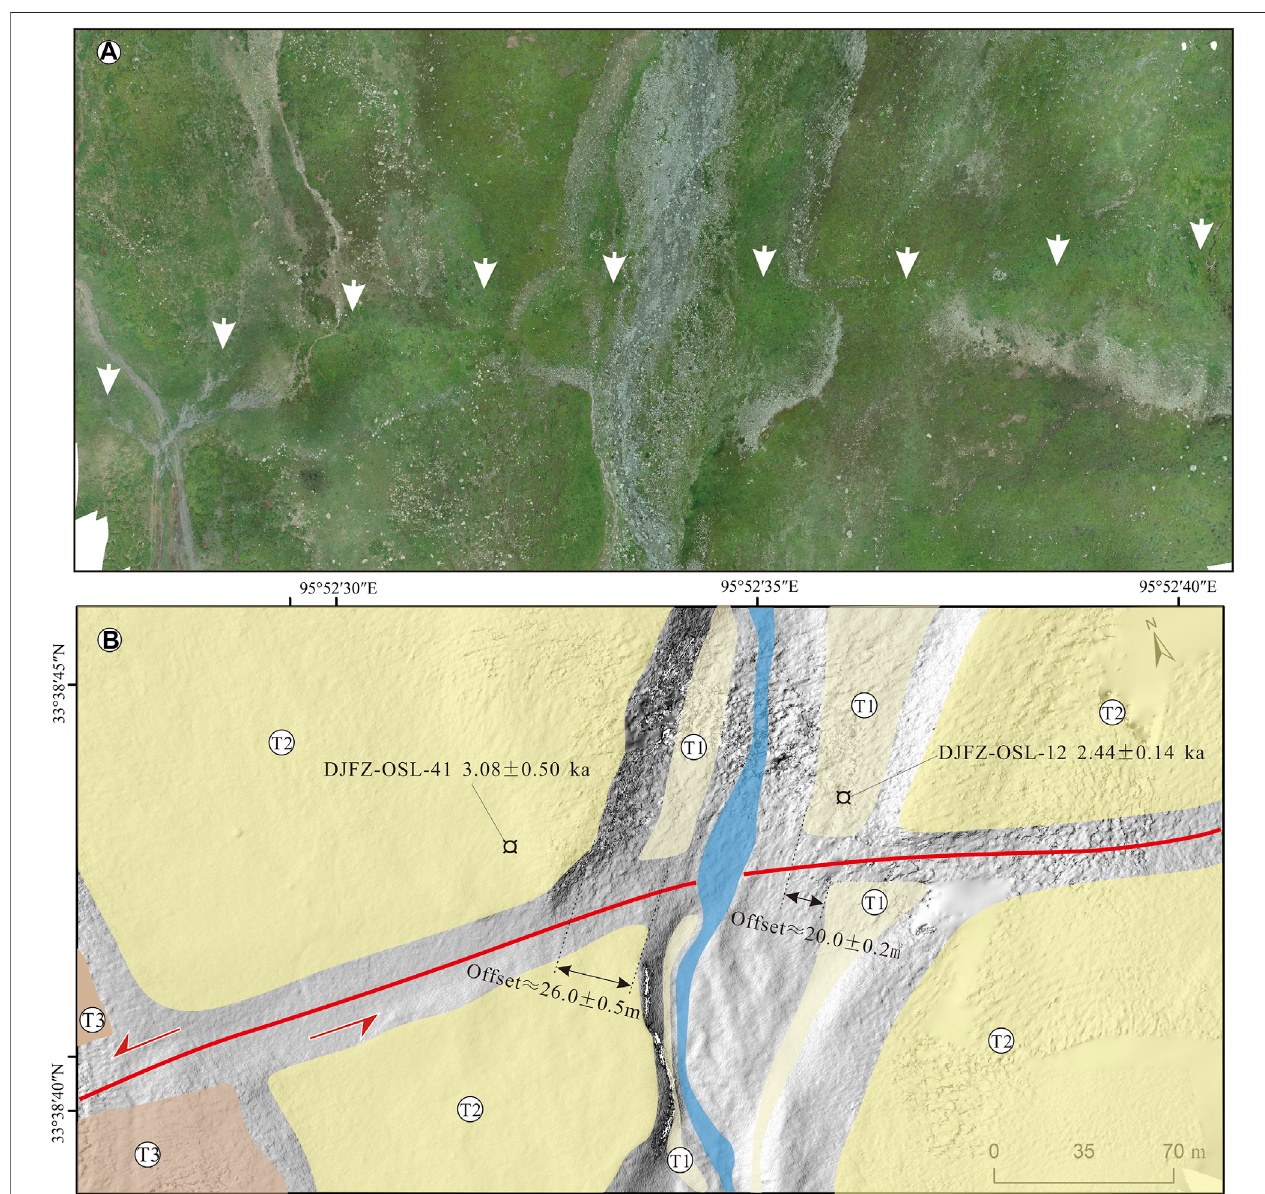
FIGURE 13 | Tectonic geomorphic features south of Riqing village in the middle section of the DJF (the study site is marked in Figure 3 M). (A) The orthophoto imagetakenfrom adroneshows thatthefaultactivity displaced thegullyandterraces,andthewhitearrows inthemapdelineatethefaulttrace. (B) Interpretedmapand fi eld investigation hint that the horizontal displacements of terraces T1 and T2 are ~20.0 ± 0.2 m and 26.0 ± 0.5 m, respectively. The red lines in the map represent the surface-rupture traces.